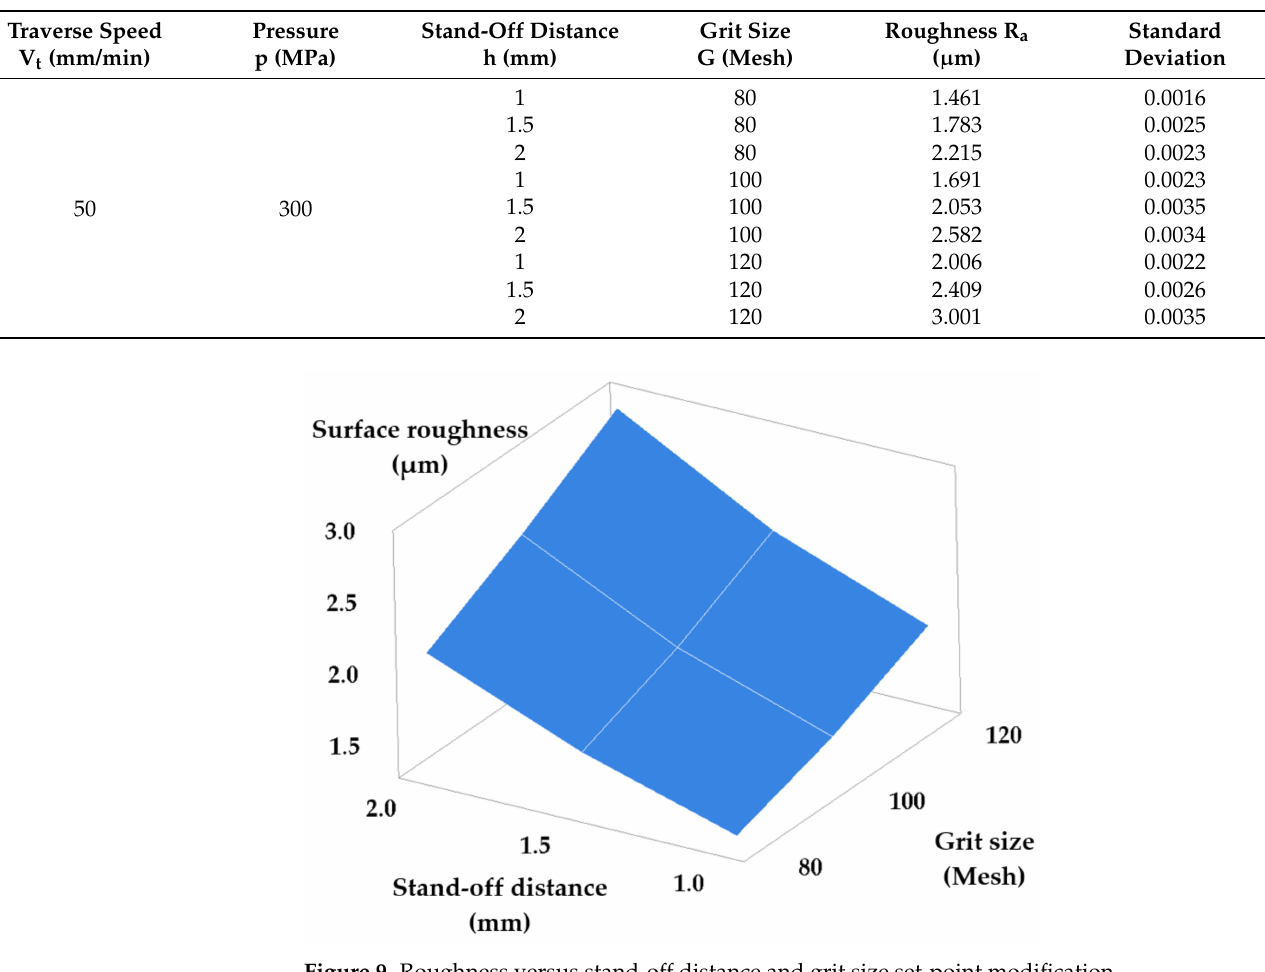
Figure 9. Roughness versus stand-off distance and grit size set-point